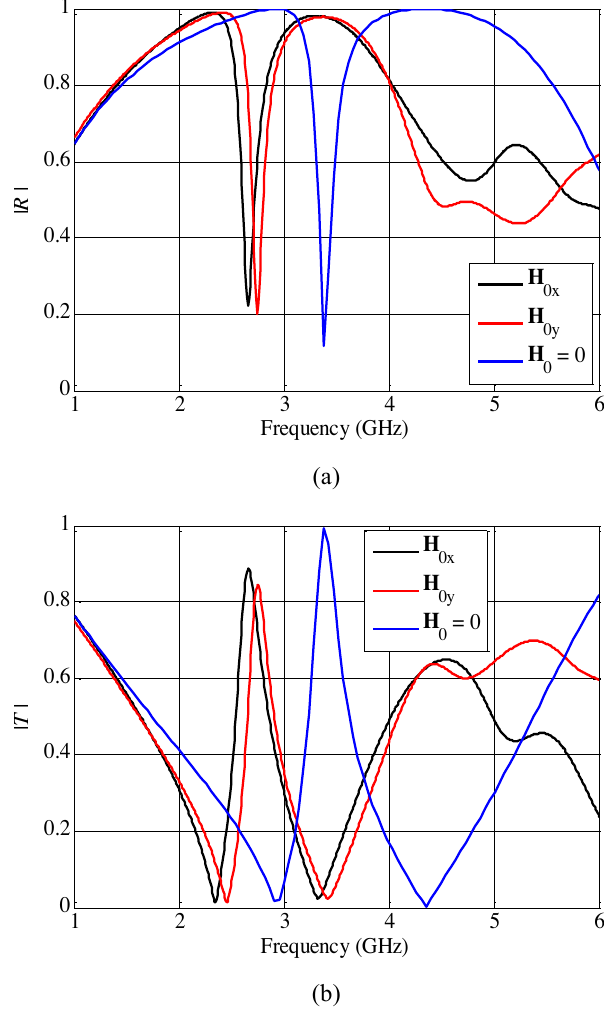
Figure 2. Reflection (a) and transmission (b) spectra of array placed on ferrite substrate, ω